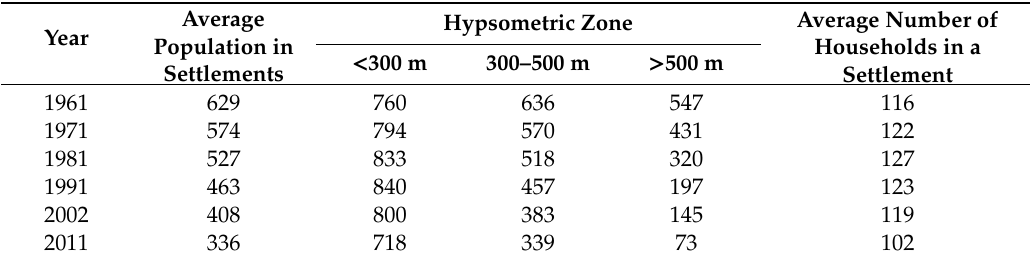
Table 4. Average population and number of households in rural settlements in the Jablanica River Basin, 1961–2011.